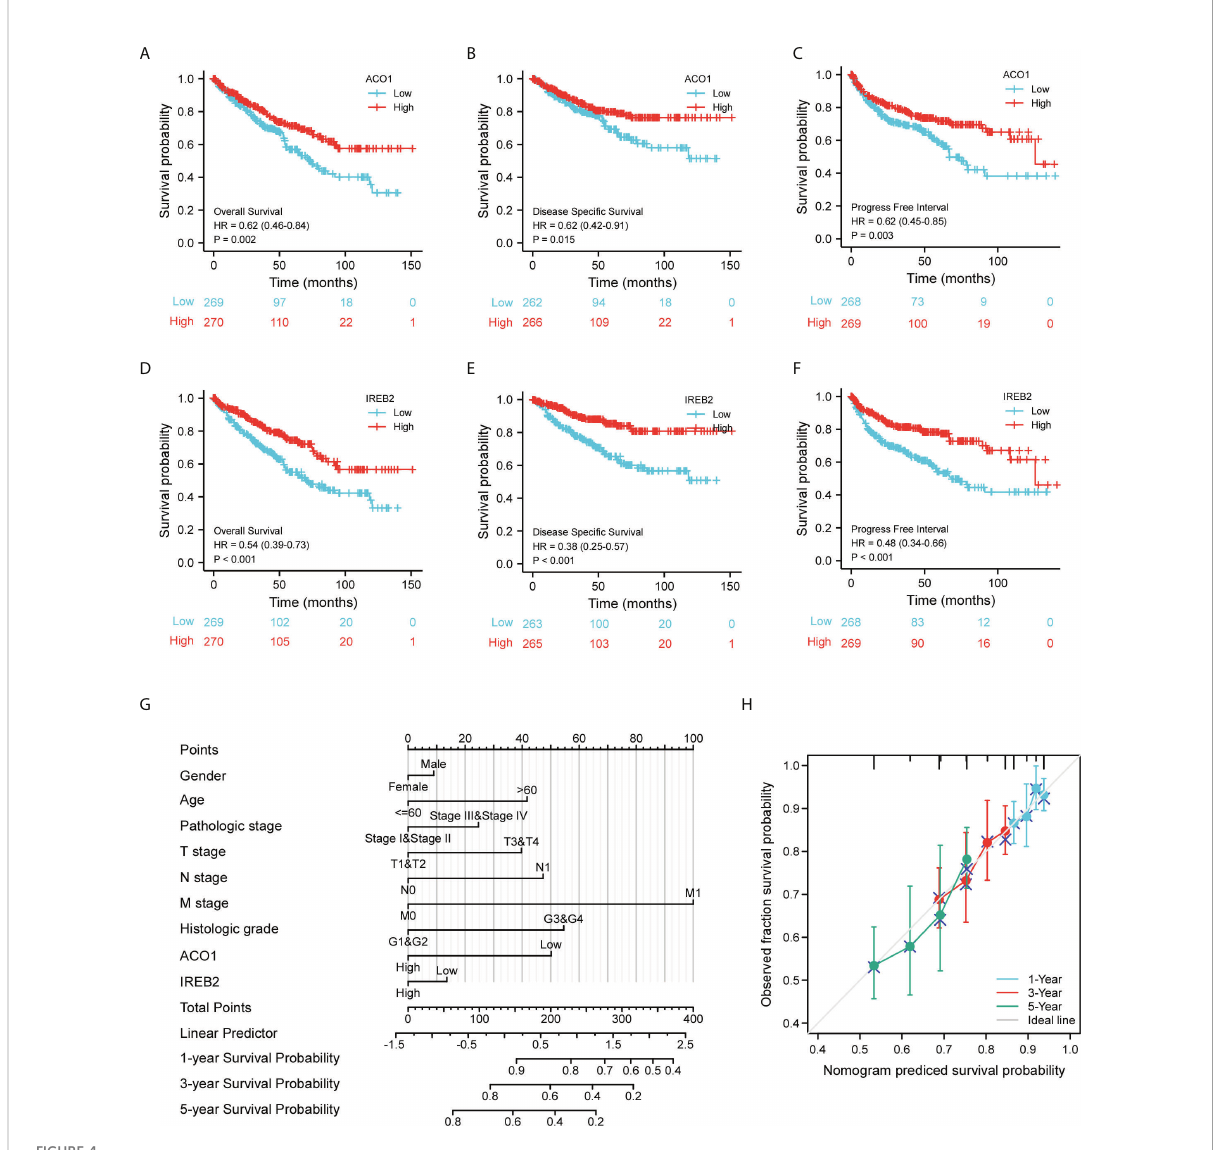
FIGURE 4 Evaluation for the prognostic value of ACO1 and IREB2 in KIRC patients of TCGA cohort. (A – C) Survival curves of ACO1 were shown for overall survival (OS) (A) , disease-speci fi c survival (DSS) (B) , and progress-free interval (C) . (D – F) Survival curves of IREB2 were shown for OS (D) , DSS, (E) and progress-free interval (F) . (G) Nomogram for predicting the probability of 1-, 3- and 5-year OS for KIRC patients of the TCGA cohort. (H) Calibration curves for nomogram predictions. The calibration curves for predicting 1-, 3-, and 5-year OS for KIRC patients of the TCGA cohort. TCGA, The Cancer Genome Atlas; KIRC, kidney renal clear cell